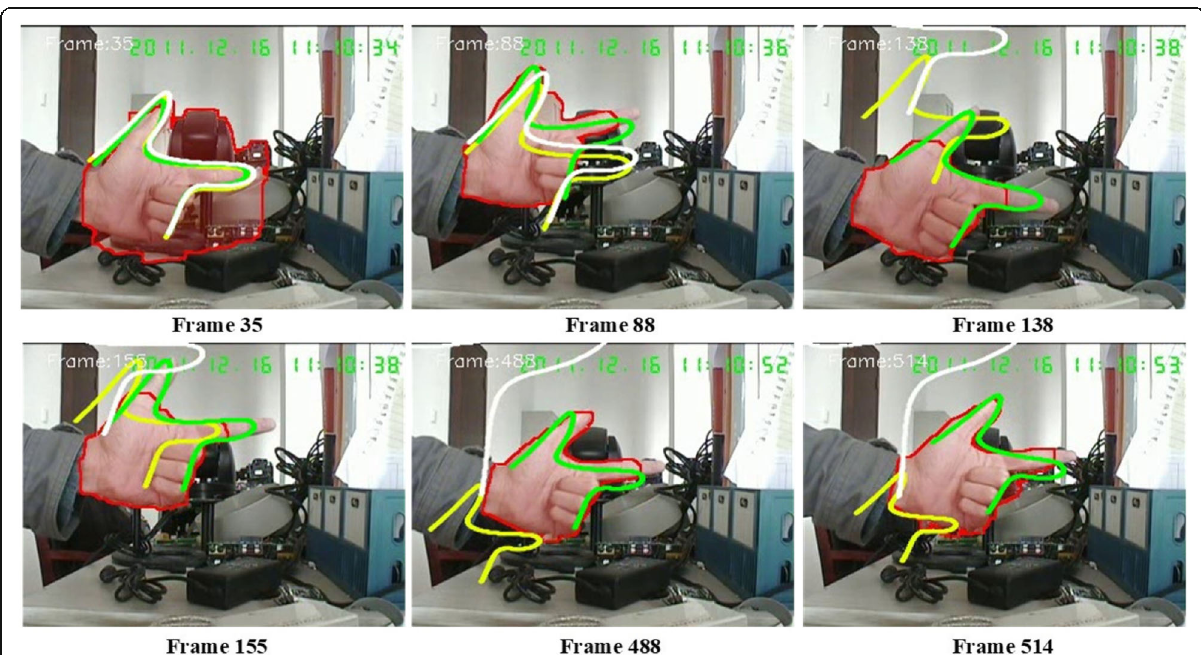
Fig. 5 Tracking result of Hand3. Yellow — UKPF, white — MHMM-UPF, red — Hough Tracker, green — proposed method